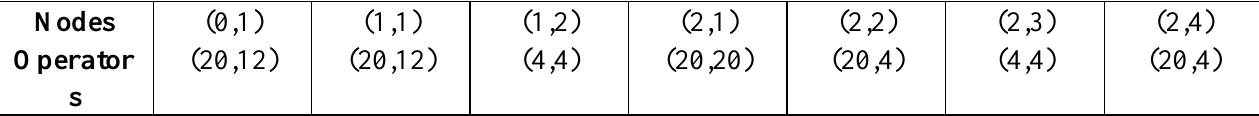
Table 3. Optimal predicting operator and updating operator for